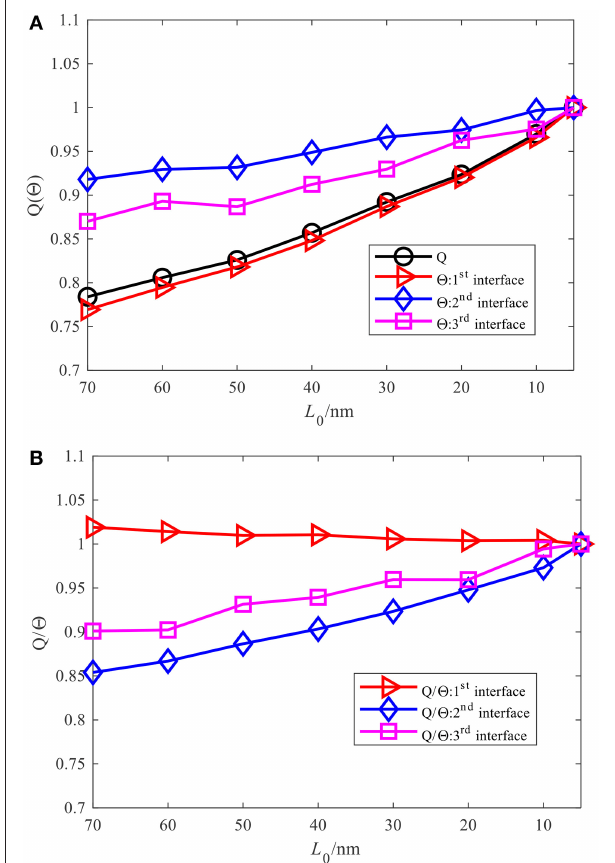
FIGURE 10 | The non-dimensional heat flux and non-dimensional temperature jump at the interfaces and their ratios vs. thickness of one layer: (A) the non-dimensional heat flux and non-dimensional temperature jump of the 1st, 2nd, and 3rd interface vs. thickness of one layer, with Q = q ave / q ave,0 and 2 = 1 T /( 1 T ) 0 , where q ave,0 and ( 1 T ) 0 are heat flux and temperature jump for L 0 = 5nm case. (B) The ratios of the non-dimensional heat flux and non-dimensional temperature jump vs. thickness of one